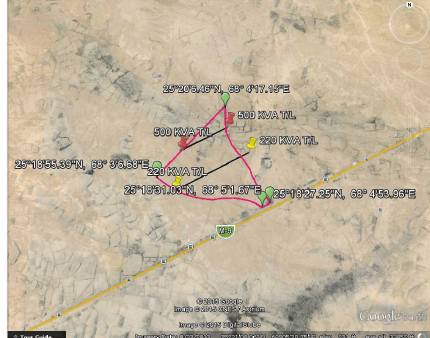
Figure 1: Land coordinates on Google map at the proposed solar